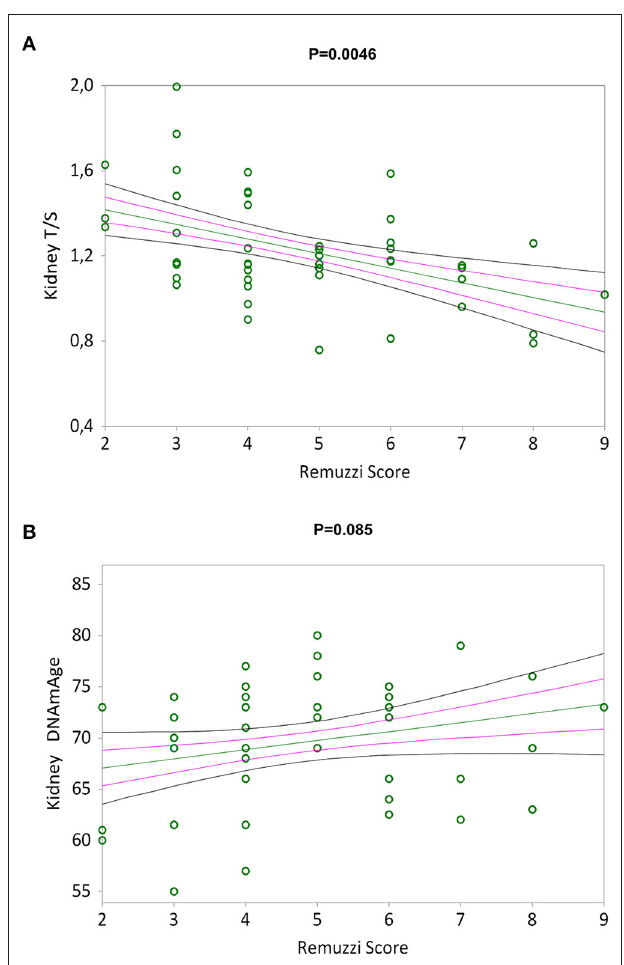
FIGURE 3 | TL and DNAmAge of the kidneys and the Remuzzi-Karpinski score correlations. Non-parametric linear regression plot showing correlations between TL (A) and DNAmAge (B) of the donors kidneys and the Remuzzi-Karpinski score (Kendall’s rank correlation coefficient tau b = − 0.310 and Kendall’s rank correlation coefficient tau b = 0.192). Mean, Standard Error (SE) and 95% coefficient intervals (CI) are represented as green, pink and black lines,